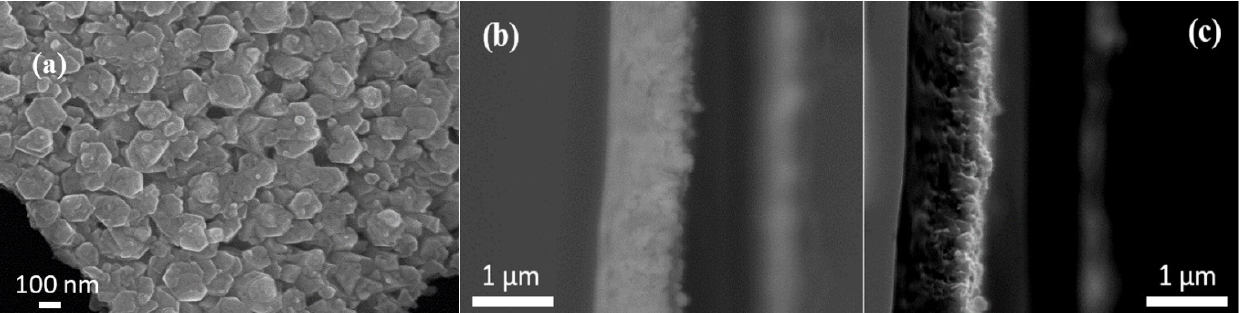
Figure 7. Micrograph of ZnO:Al thin films on glass ( a ) at normal incidence, ( b ) in cross-section with secondary electrons, and ( c ) in cross-section with backscattered electrons.